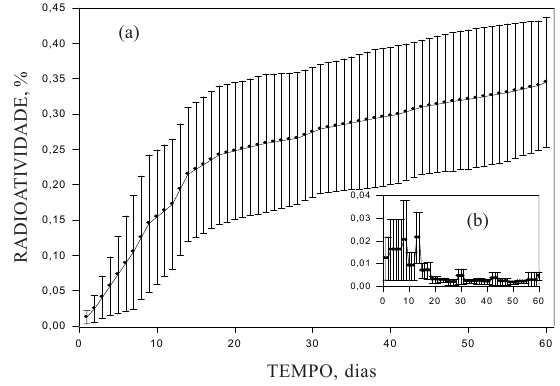
Figura 2. Percentagem de produtos radioativos voláteis liberados nos 60 dias de experimento (média dos 4 microcosmos) (a = % acumulada, b = % diária). As barras verticais indicam o